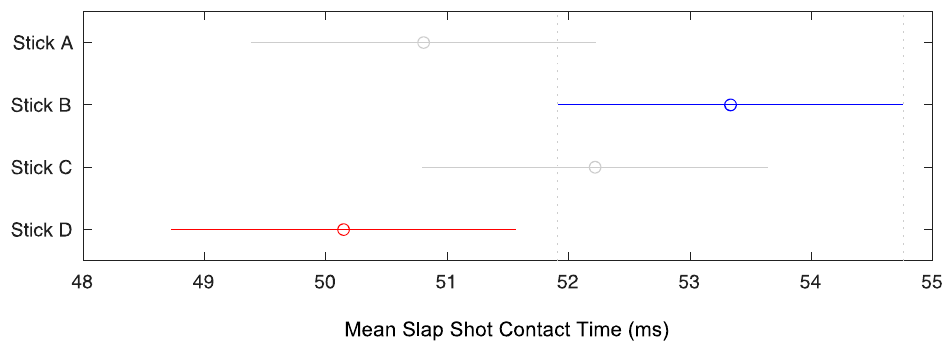
Figure 4. Mean slap shot blade–puck contact time (ms) ± standard error. The means of Stick B and Stick D are significantly different.